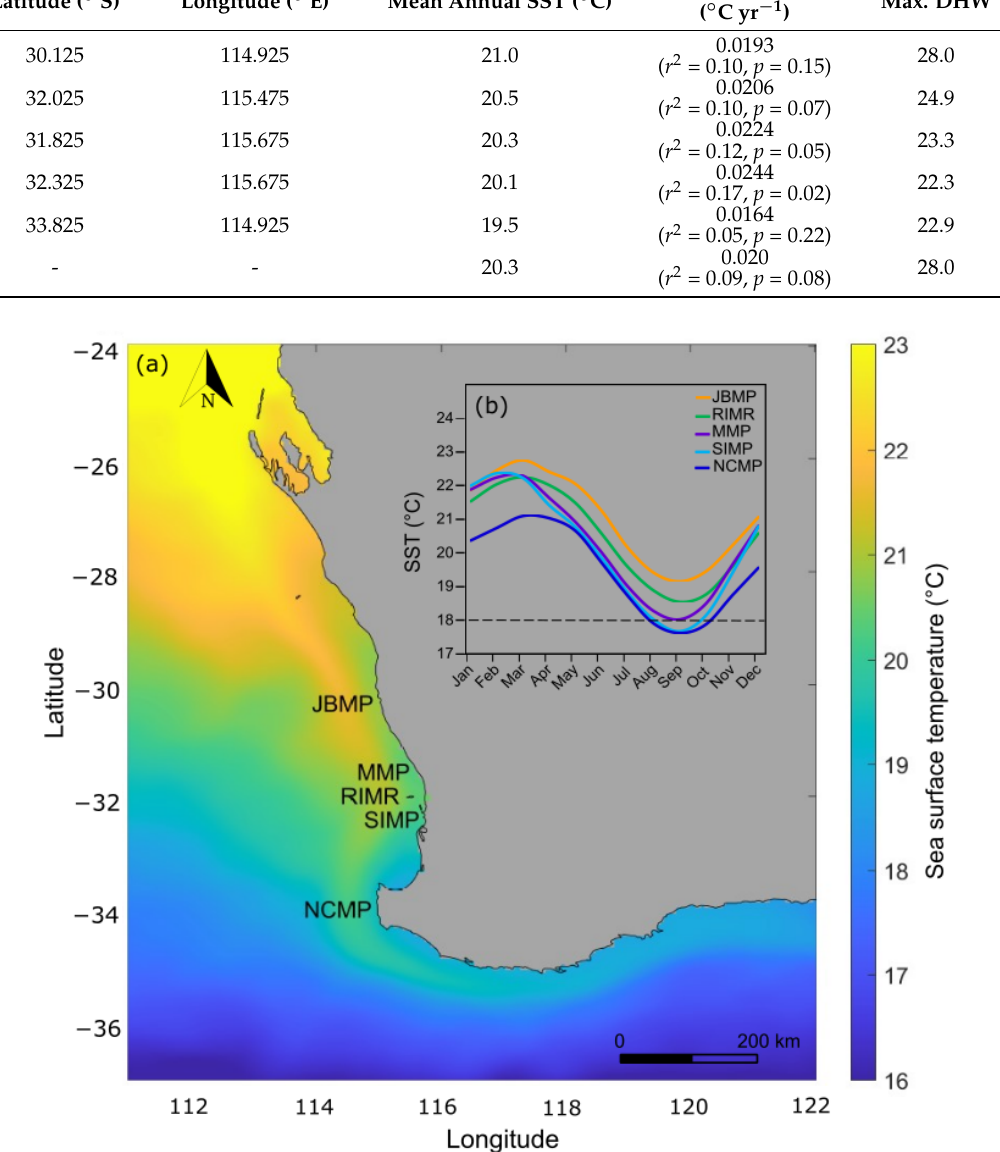
Table 1. The coordinates (latitude and longitude), mean annual sea surface temperature (SST) between 1986 and 2019, the long-term increase in SST based on monthly mean summer (March) temperature, and the maximum degree heating weeks (DHW).